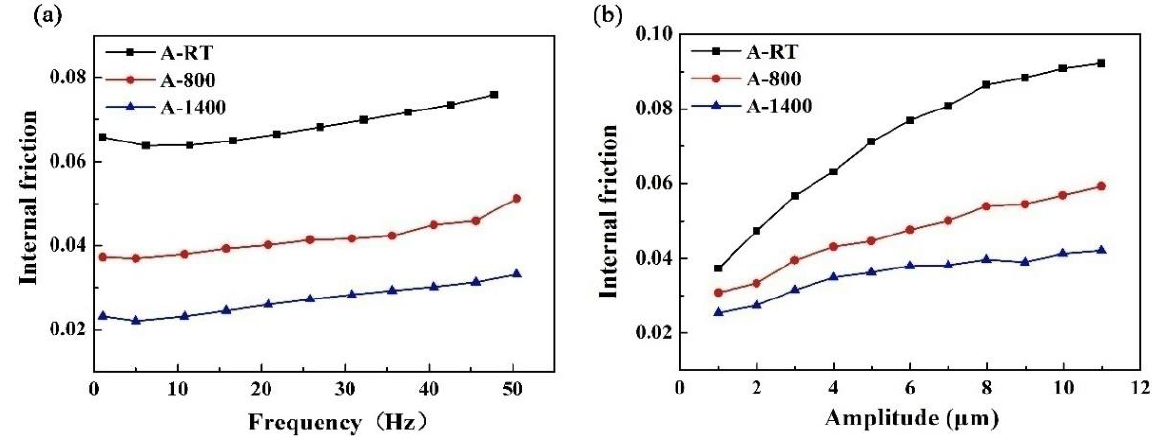
Figure 8. Plots of the internal friction of the composites versus frequency ( a ) and amplitude ( b ). It is noteworthy that the internal friction increases with frequency in the range of 1